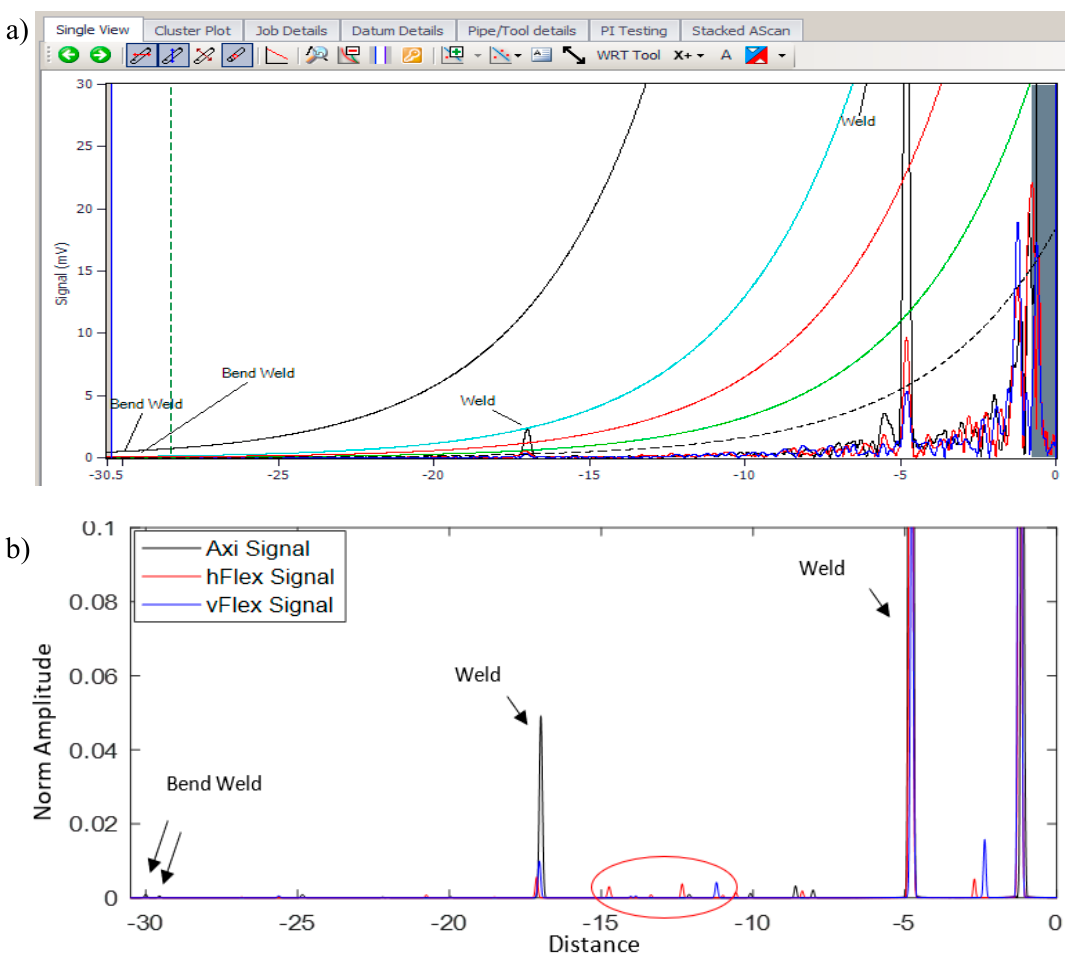
Figure 14. Field data #2 ( a ) Teletest data, ( b ) SSP